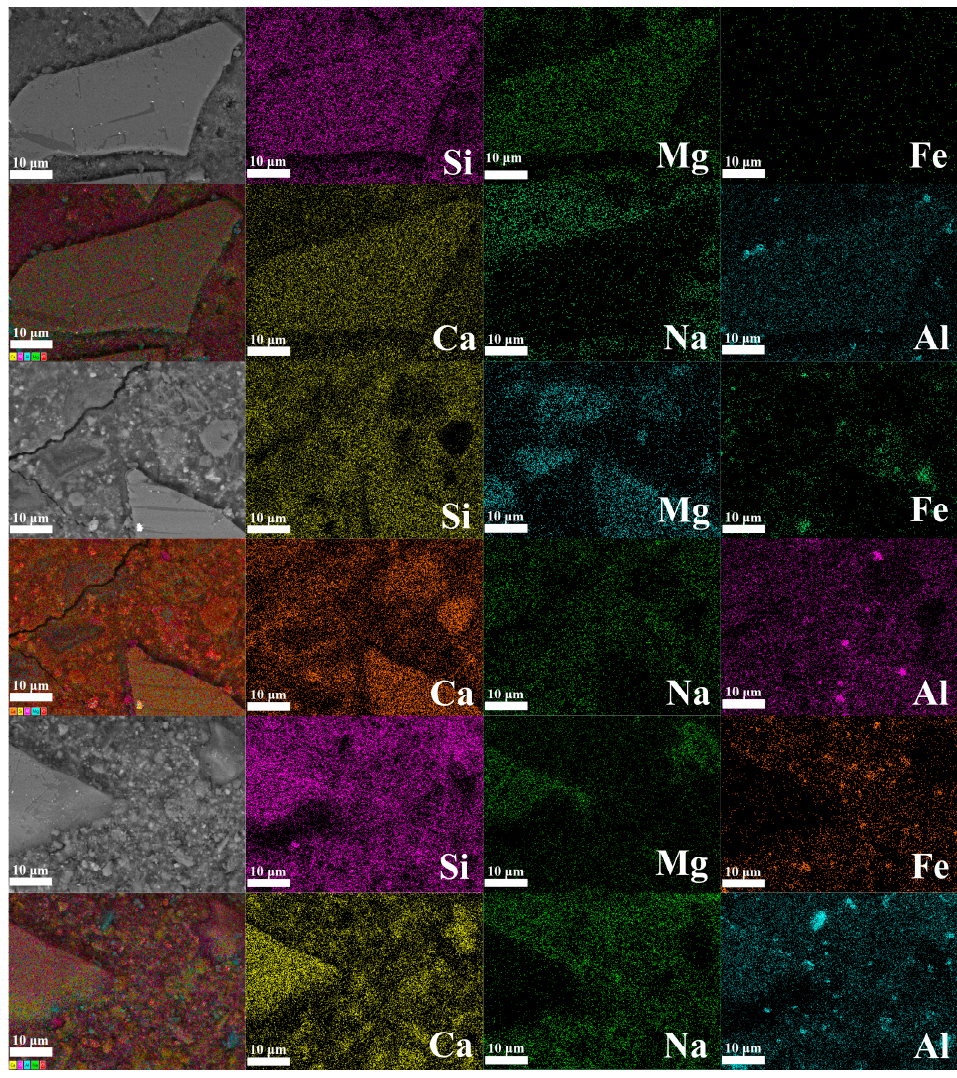
Figure 11. Elemental distribution of BSE-EDS surface sweep of RM with different additions.